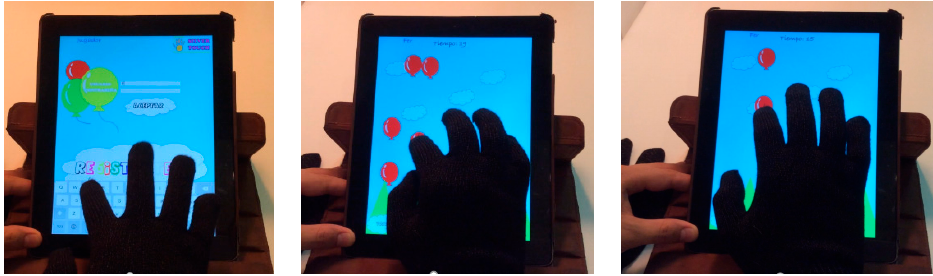
Figure 1. Game “Balloons”.